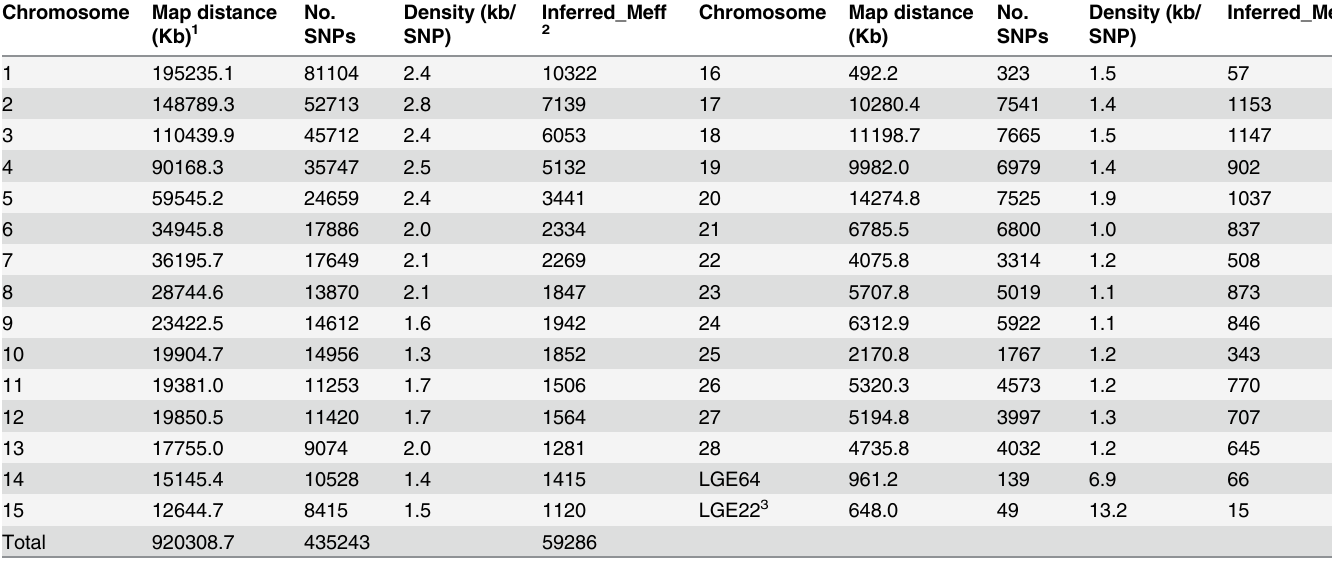
Table 1. Basic information for SNP markers on a physical map after quality control. Chromosome Map distance (Kb)